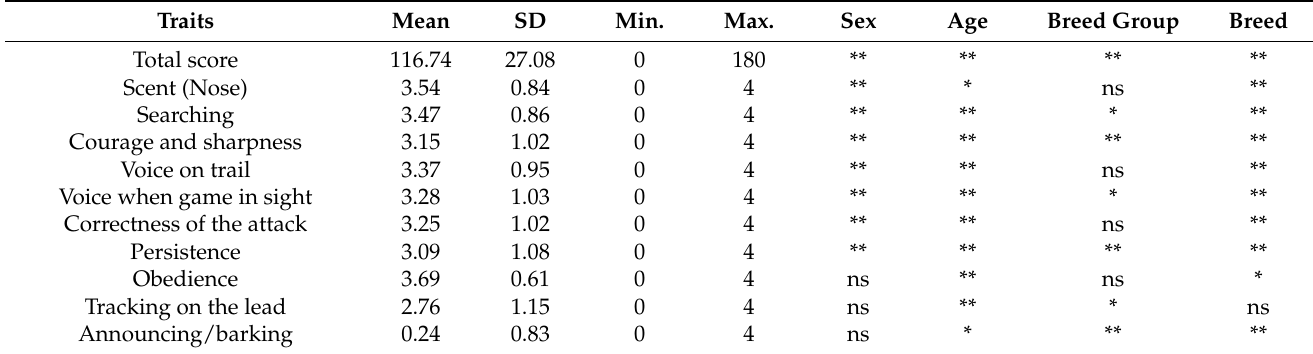
The Table 2. present results of the hunt trials for boarhounds. In hunt trials for boarhounds, dogs achieved scores from 0 to 180 points. The mean score was 116.74. The boarhounds obtained the highest results in obedience (3.69), scent (nose) (3.54), and searching (3.47), while the lowest results were scored in announcing/barking (0.24), and tracking on the lead (2.76). Table 2. Descriptive statistics of the results of the hunt trials for boarhounds.